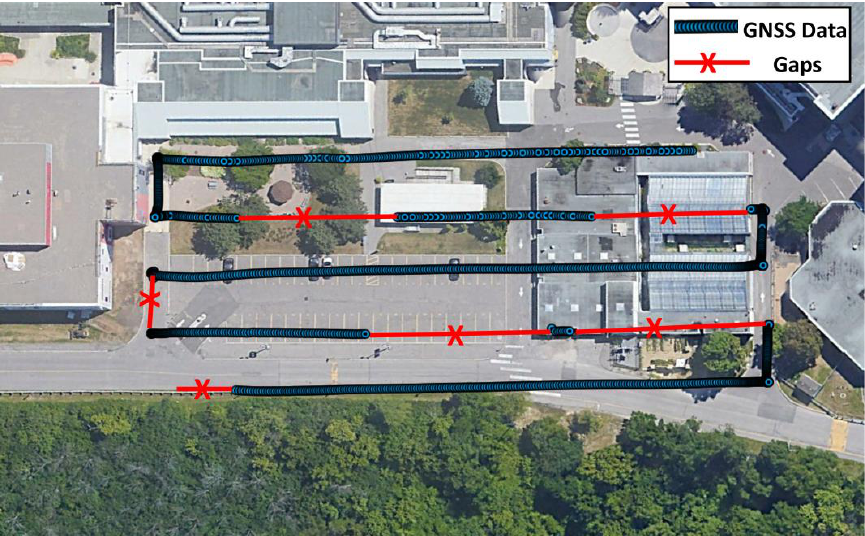
Figure 3. GNSS data gaps due to an unexpected antenna malfunction.